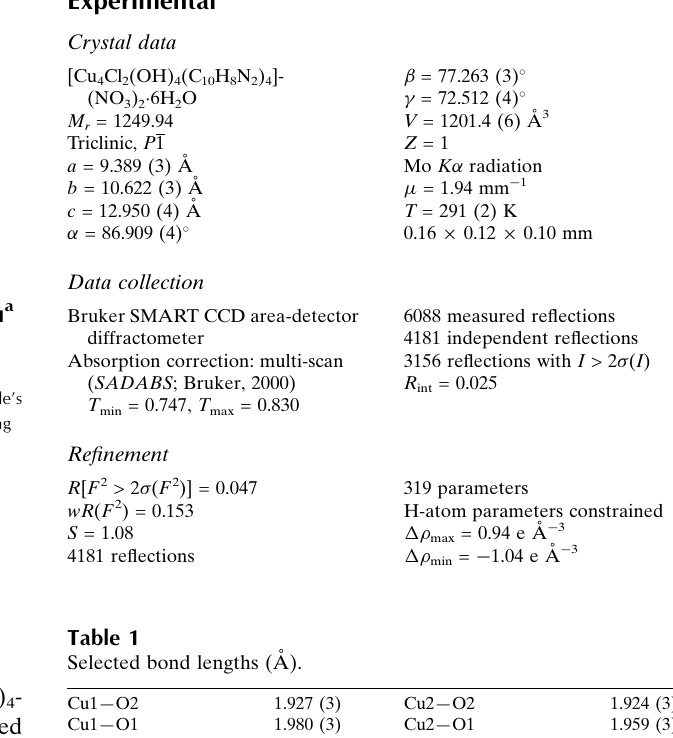
centre of symmetry. The metal atoms display a distorted tetragonal-pyramidal coordination geometry, and are linked